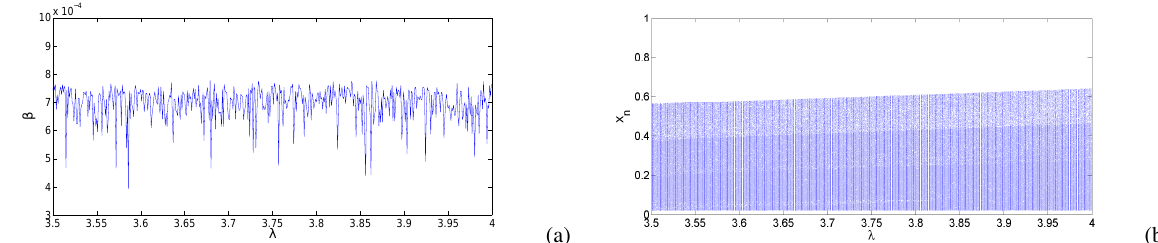
Fig. 1 (a)Graph of the Lyapunov exponent of the map (2) with respect to the parameter λ , where x b = 0 . 2, λ ∗ = 0 . 18, (b)Bifurcation diagram of the map (2) with respect to the parameter λ , where x b = 0 . 2, λ ∗ = 0 . 18